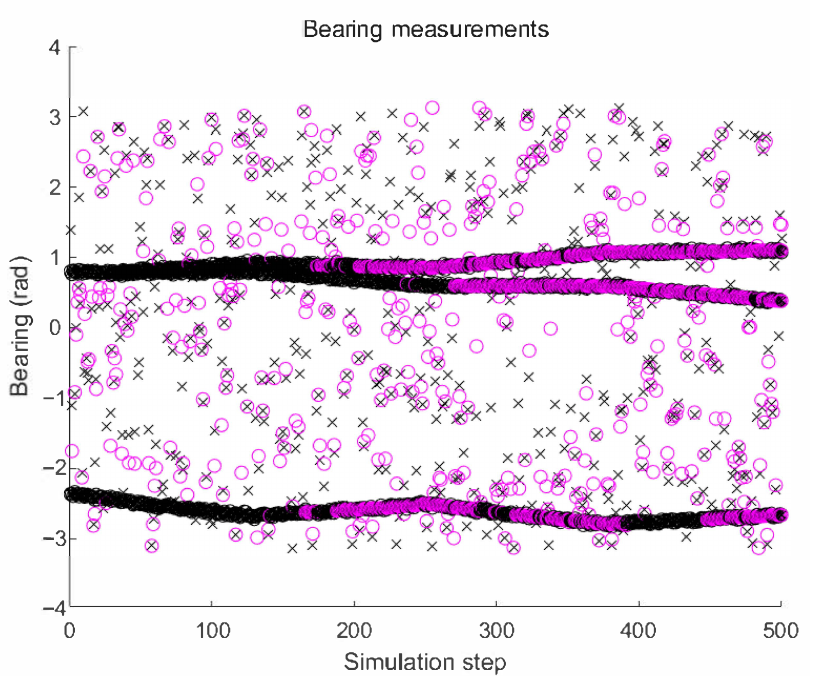
Figure 3. The bearing (in radians) change with respect to time (in seconds). In this figure, true target bearings are marked with circles. In addition, interference points are marked with crosses. The estimated target bearing is marked with magenta circles. Before the observer maneuver at 125 s, true target bearings are not tracked by the estimated target bearing (magenta circles). However, as time goes on, true target bearings are tracked by estimated target